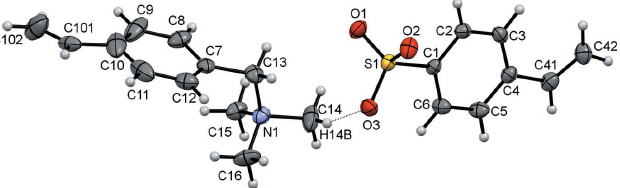
Figure 1 The asymmetric unit of the title compound showing the atom numbering with ellipsoids drawn at the 50% probability level. The C—H (cid:2)(cid:2)(cid:2) O hydrogen bond linking the two components is drawn as a dotted black line. For clarity, only the major disorder component of the vinyl substituent on the benzene ring of the cation is shown.